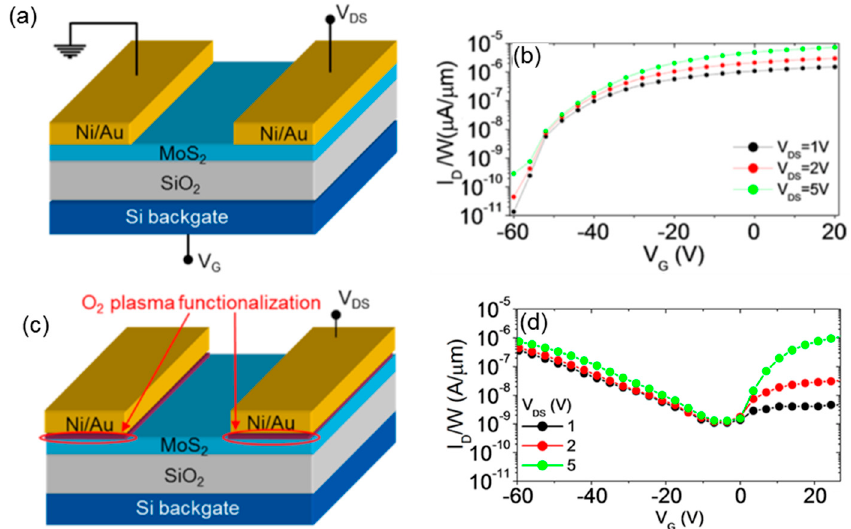
Figure 7. Schematic illustrations of back-gated field-effect transistors with source and drain contacts deposited on pristine MoS 2 ( a ) or on areas selectively exposed to the O 2 plasma for 600 s ( c ). I D -V G characteristics for a pristine MoS 2 transistor ( b ) and for a transistor with O 2 functionalized contact areas ( d ). Adapted with permission from Reference [29], copyright from the American Chemical Society 2017.